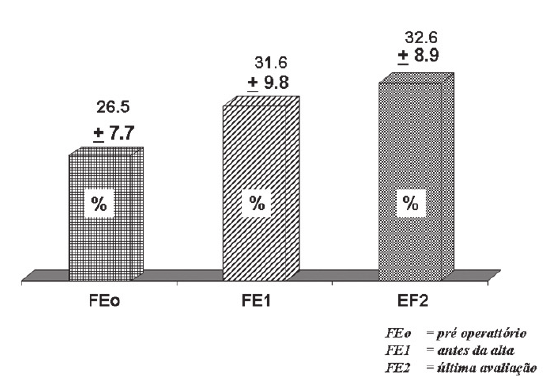
Fig. 3 - Fração de ejeção no pré-operatório, antes da alta hospitalar